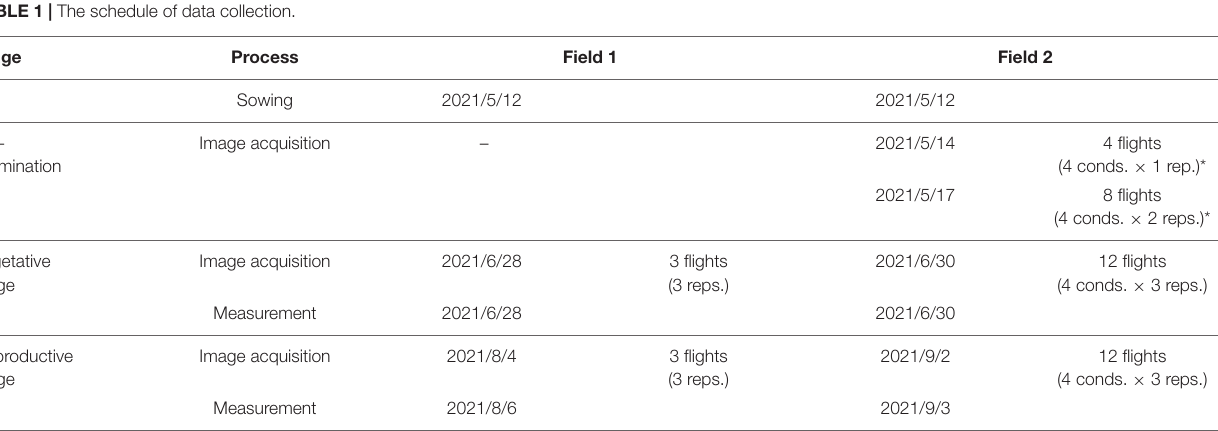
FIGURE 2 | An overview of two fields of maize used in this study. Light blue (Field 1) and orange (Field 2) solid lines show the plots. Dash lines show the analysis region of each field. White circles around or in Field 2 show the locations of GCPs. Red rectangles show ROIs on rows (inner ROIs). Blue rectangles show ROIs around the field (outer ROIs). TABLE 1 | The schedule of data